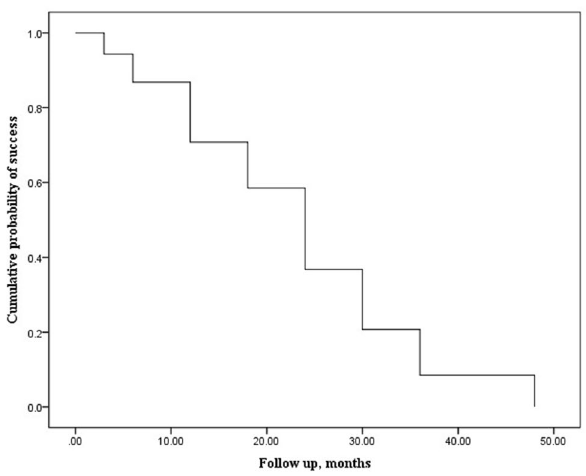
Figure 1. Kaplan–Meier survival analysis based on exodrift after surgery.